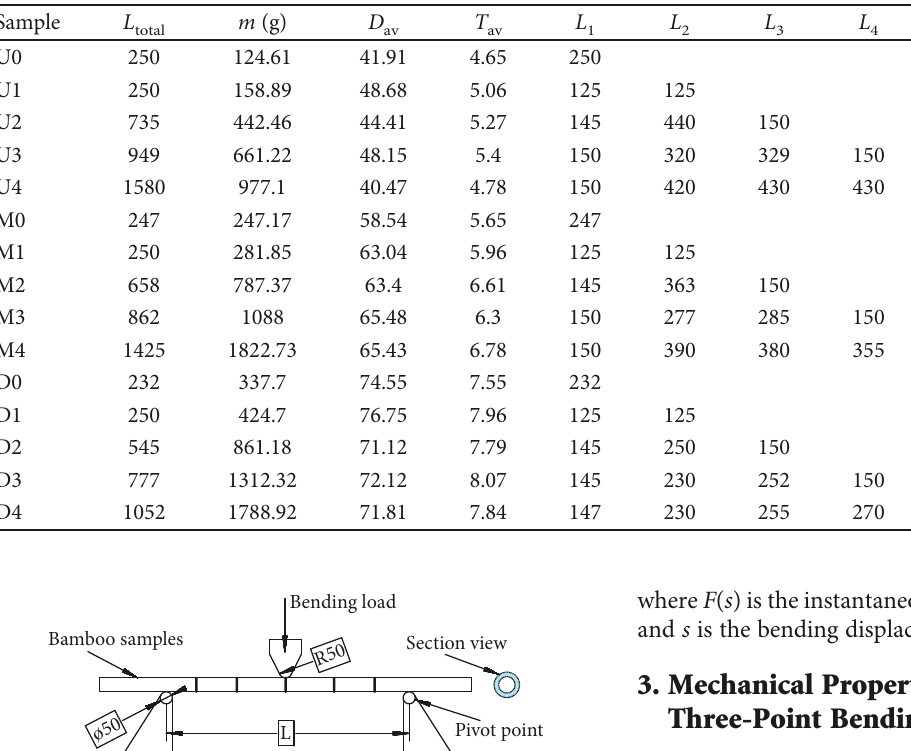
Table 1: Structure parameters of bamboo samples (unit: mm).